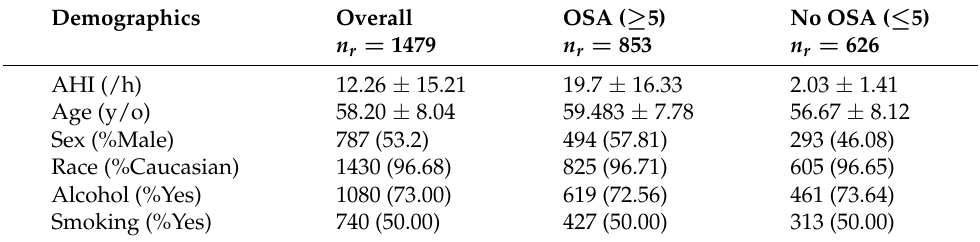
Table A1. Demographic characteristics of cohort expressed as mean ± standard deviation.